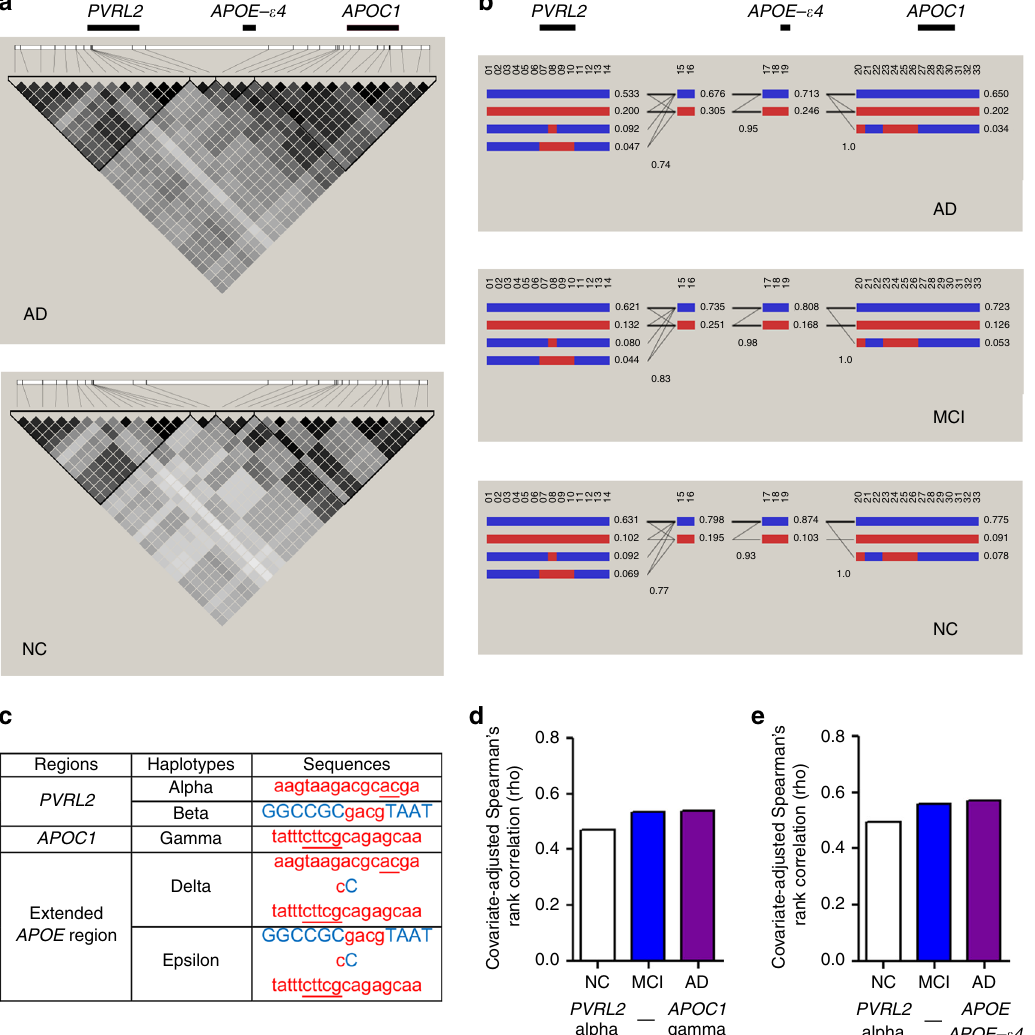
Fig. 2 Haplotype structure of AD-associated risk variants in the Chinese AD cohort. a Pairwise LD plot of the 33 selected variants in LD with the potential risk variants in different phenotypic groups. The color map corresponds to the pairwise r 2 values between variants, with nine potential risk variants located in the PVRL2 , APOE , and APOC1 loci marked at the top panel, respectively. b Haplotype analysis of the 33 selected variants among different phenotypic groups. Each column (marked with numbers) represents one of the 33 variants, with red and blue indicating the minor (i.e., AD risk) and major alleles, respectively. Each row represents a particular haplotype de fi ned by a speci fi c combination of major and minor alleles in the given haplotype blocks, with decimals on the right side specifying the frequencies of corresponding haplotypes in the given phenotypic groups. Intersecting lines represent the frequency of associations between two connected haplotypes (thin and thick lines denote associations with frequency > 1% and > 10% in the corresponding groups, respectively). c Table summarizing the identi fi ed minor haplotypes in PVRL2 , APOC1 , and extended APOE regions. Letters in uppercase blue or lowercase red denote the major and minor (risk) alleles, respectively; underlined letters highlight INDELs. d , e Pairwise correlations between the minor haplotypes of PVRL2 alpha and APOC1 gamma or APOE - ε 4 measured by Spearman ’ s partial rank-order correlation, adjusted for age, gender, and principal components in corresponding phenotypic groups (presented as Spearman ’ s ρ in the y -axis). AD Alzheimer ’ s disease, INDELs insertions and deletions,